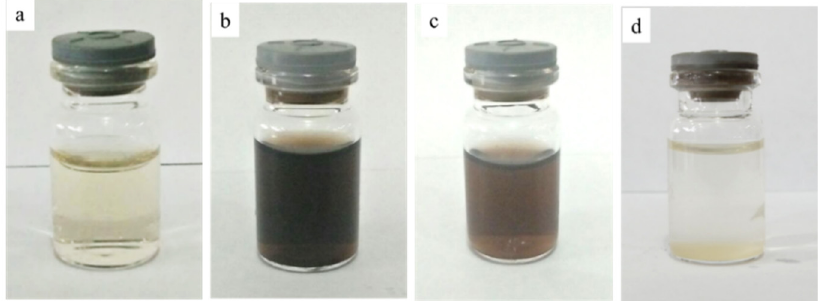
Figure 1. Visual appearances of AgNPs colloidal samples: ( a ) Baked 1, ( b ) Baked 10, ( c ) Baked 100 and ( d ) Unbaked 10.